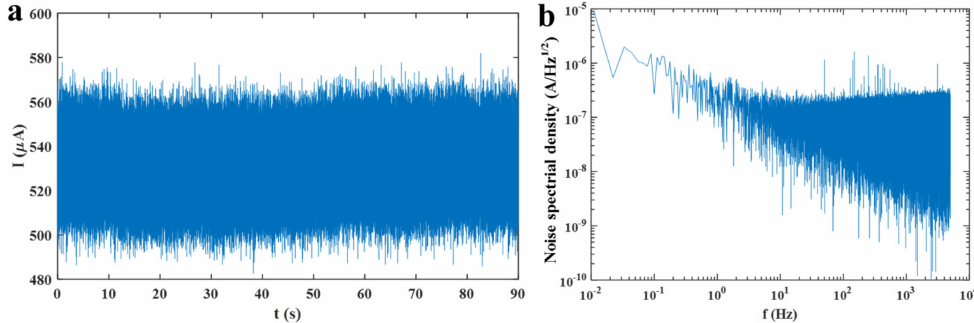
Figure A6. Noise level determination. ( a ) The dark current waveform of the graphene AFPD for V ds = 0.3 V corresponding to the same conditions in which we measured its photoresponsivity. ( b ) Noise–power density changing with frequency.